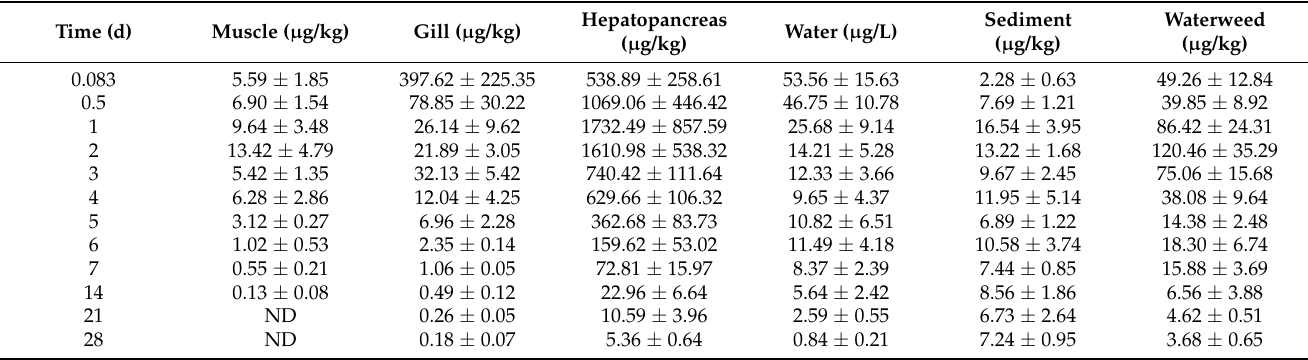
Table 6. Pendimethalin quantification in test ponds sprayed with the recommended dose of 0.27